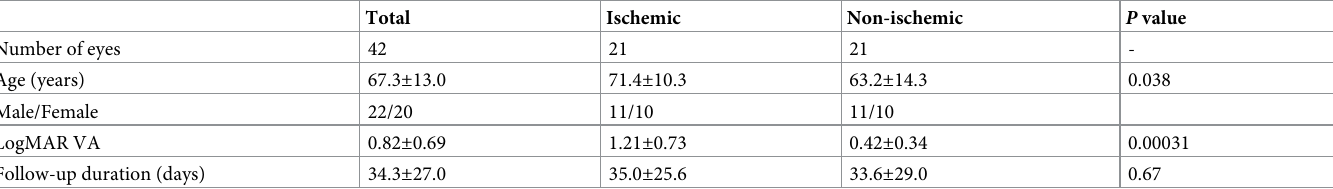
Table 1. Subject demographics.